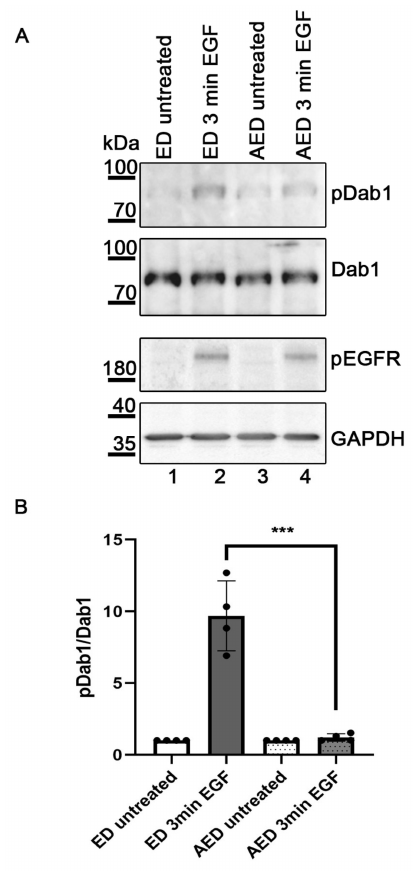
Figure 5. Presence of ApoER2 diminishes EGF-mediated Dab1 phosphorylation. Western blot analysis of HEK293 ( A ) cells expressing EGFR and Dab1 (Lanes 1 and 2, ED) or ApoER2, EGFR and Dab1 (Lanes 3 and 4, AED). Cells were either left untreated (Lanes 1 and 3) or treated with human EGF (10 ng/mL) for 3 min (Lanes 2 and 4). Immunoprecipitation using a Dab1 specific antibody was performed (Ab 54). Dab1 phosphorylation levels (Panel 1) were detected using an antibody against phosphorylated tyrosine residues (Ab PY99). The blots were stripped and re-probed for Dab1 using Ab D4 (Panel 2). Extracts were blotted with an antibody specific for EGFR phosphorylation (Tyr 1173) (Panel 3) and GAPDH was used as a loading control (Panel 4). ( B ) The anti-phosphotyrosine signal was normalized to the anti-Dab1 signal and relative levels of phosphorylated Dab1 from 4 independent experiments in HEK293 are presented. The level of Dab1 phosphorylation in the untreated control was set to 1. Data were analyzed by an unpaired, two-tailed t -test, *** p ≤ 0.001; dots, number of experiments. Error bars represent standard